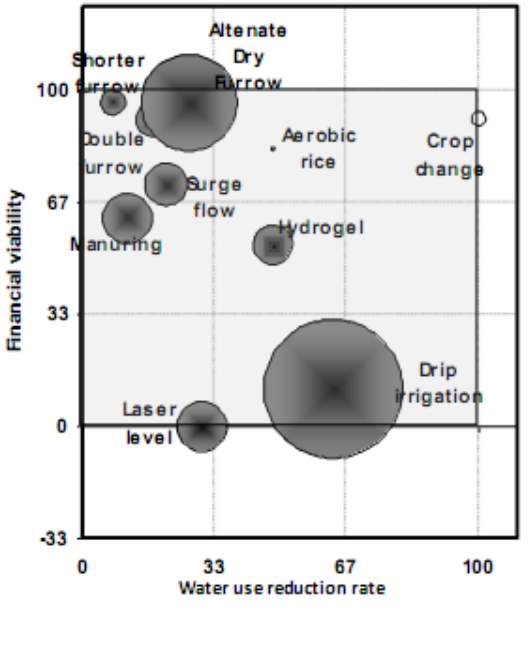
Figure 1. Water use reduction rate, economic efficiency, and financial viability of water conservation techniques. The size of the bubbles corresponds to economic efficiency. Note: Crop change is left blank since it gained negative gross